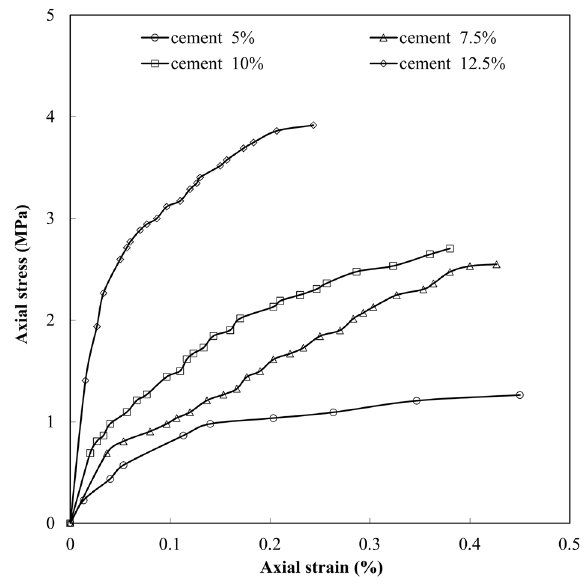
Fig. 8 The axial stress–strain graph for CSG materials with different cement contents after curing age of 28